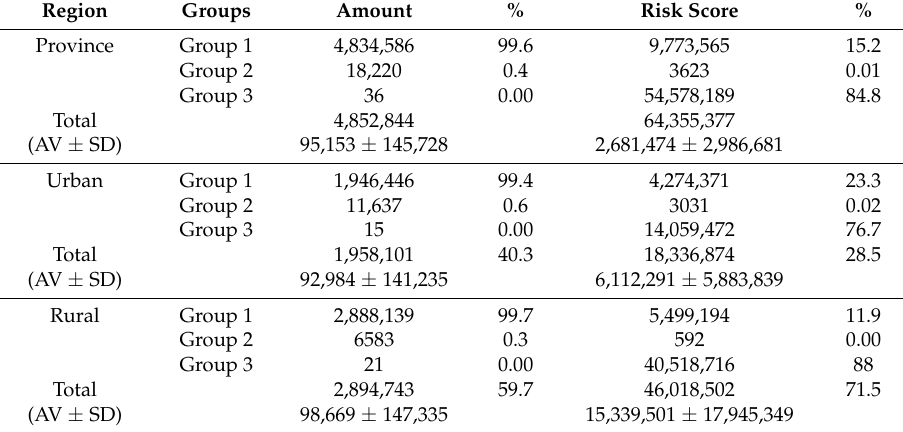
Table 4. Proportions of emissions by region using amounts and risk